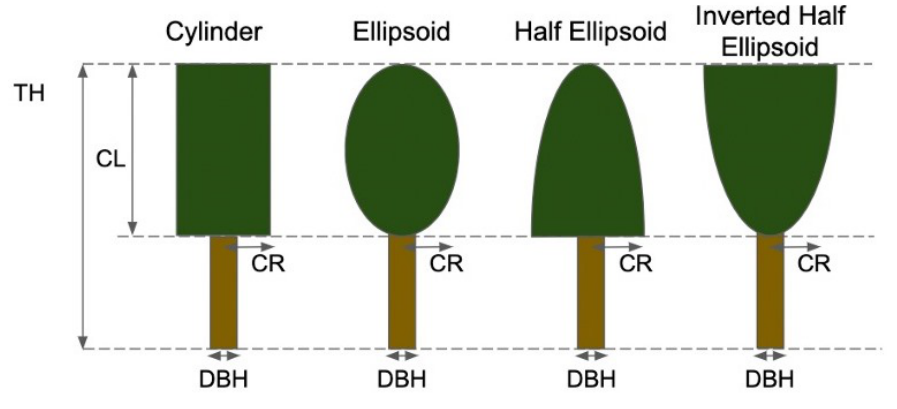
Figure 4. Canopy shapes used for the virtual forest. The canopy structures are tree height (TH), canopy length (CL), canopy radius (CR) and diameter at breast height